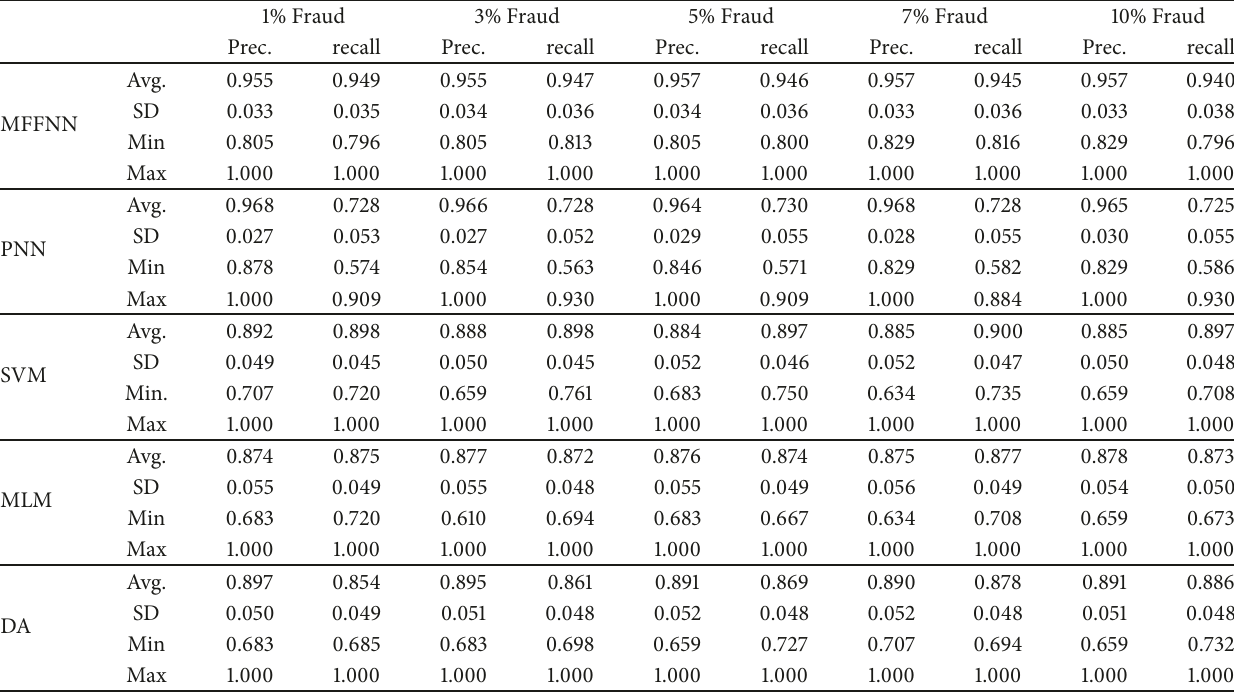
Table 4: Descriptive statistics of the performance measures obtained from 1000 iterations segmented by different rate of fraudulent companies, and for training sample size of 300 and test sample size of 100.